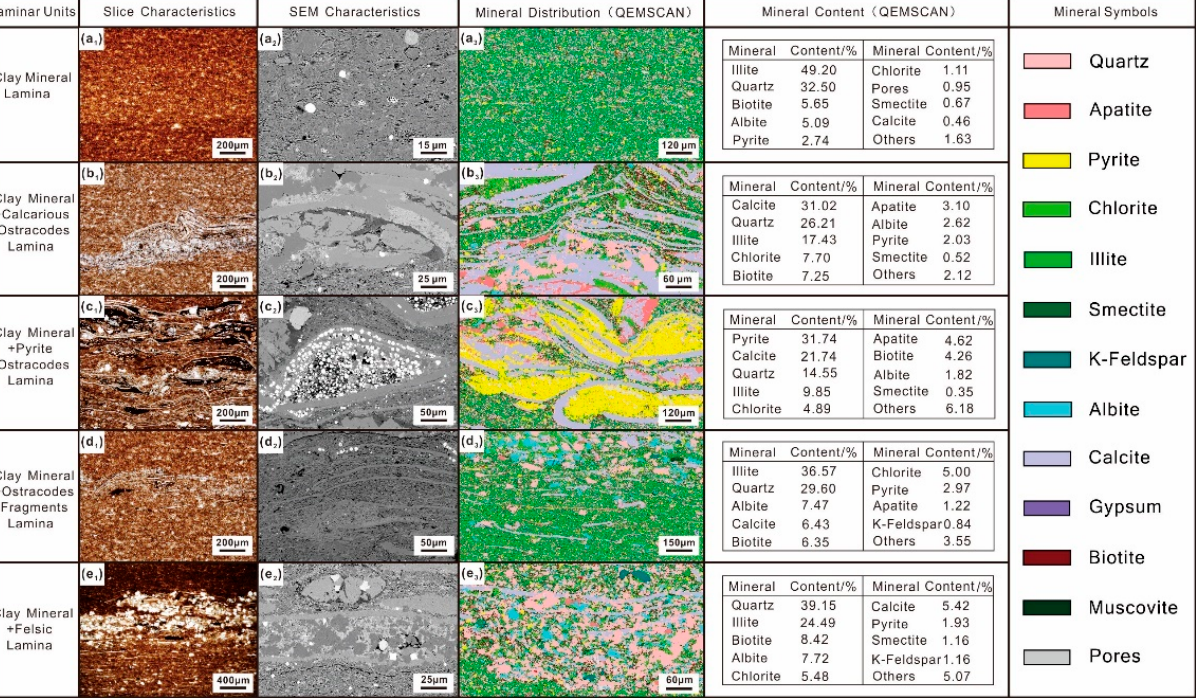
Figure 4. Mineral characteristics and inorganic pore types of the different laminae. ( a 1 –a 3 ) are UA, ( b 1 –b 3 ) are UB and ( c 1 –c 3 ) are UC. ( a 1 ) Calcite dissolved pores and surrounding clay mineral intra- granular pores; ( a 2 ) illite intragranular dissolved pores, slit type; ( a 3 ) gypsum intragranular dis- solved pores; ( b 1 ) Ostracod shell intergranular pores, shell margin slits, Ostracod shell intragranular dissolved pores and chlorite intragranular pores; ( b 2 ) pyrite intergranular pores; ( b 3 ) clay mineral intergranular pores; ( c 1 ) quartz and albite intergranular pores; ( c 2 ) illite intragranular pores, inter- granular pores of illite and quartz; ( c 3 ) chlorite intragranular pores with pyrite developed. 5. Organic-Rich Shale Reservoir Characteristics In addition to the differences in mineral composition and organic matter content, there are also significant differences in pore types, pore throat networks, and hydrocarbon reservoir space among different types of shale laminae [4,13]. The pore structures of three different laminar units in the Qingshankou Formation of the Gulong Depression were